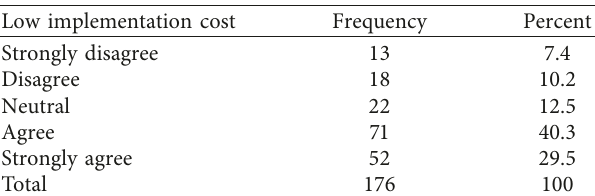
Table 2: Low implementation cost.